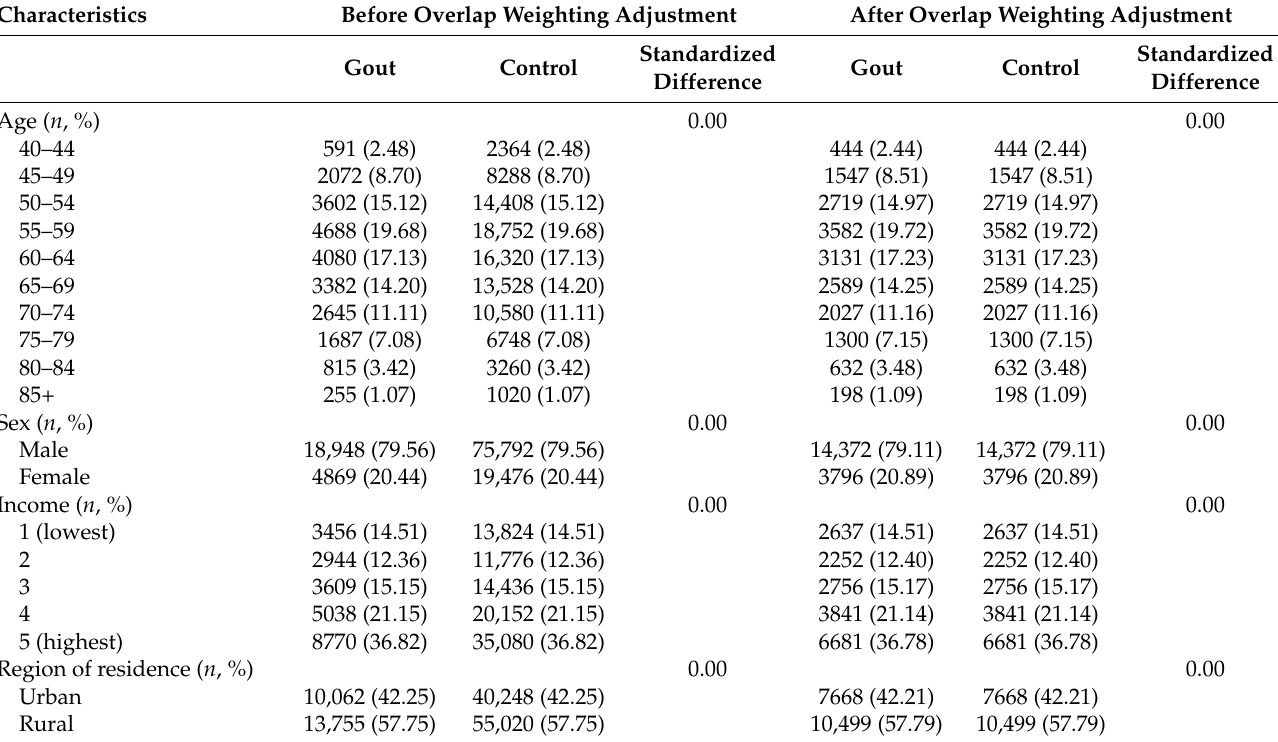
Table 1. General Characteristics of